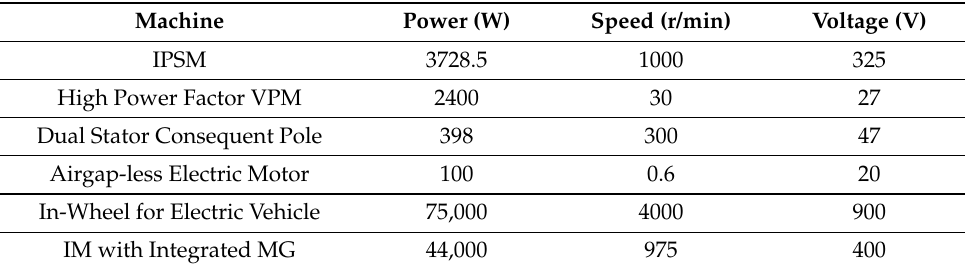
Table 1. Parameters for the machines shown in charts